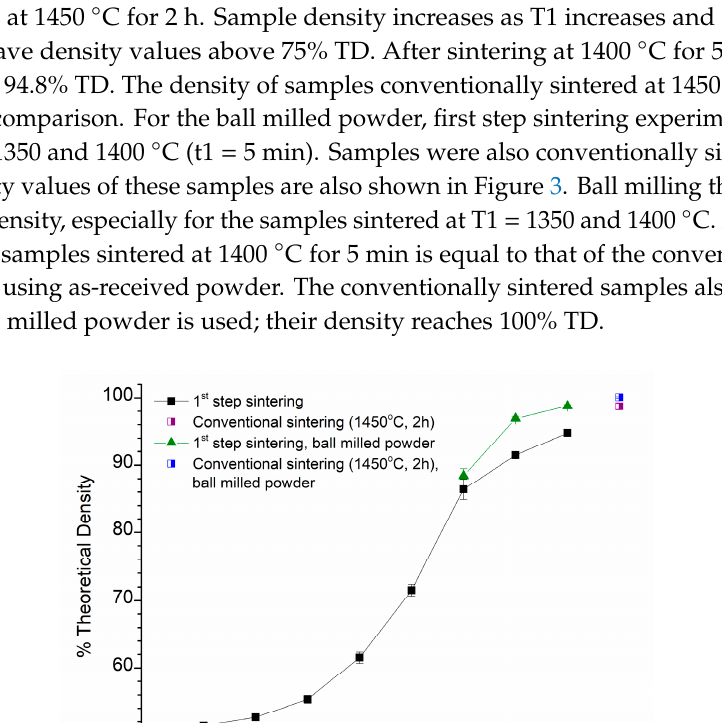
Figure 2. SEM micrographs of ( a ) secondary and ( b ) primary particles of Tosoh Zpex Smile powder after ball milling.